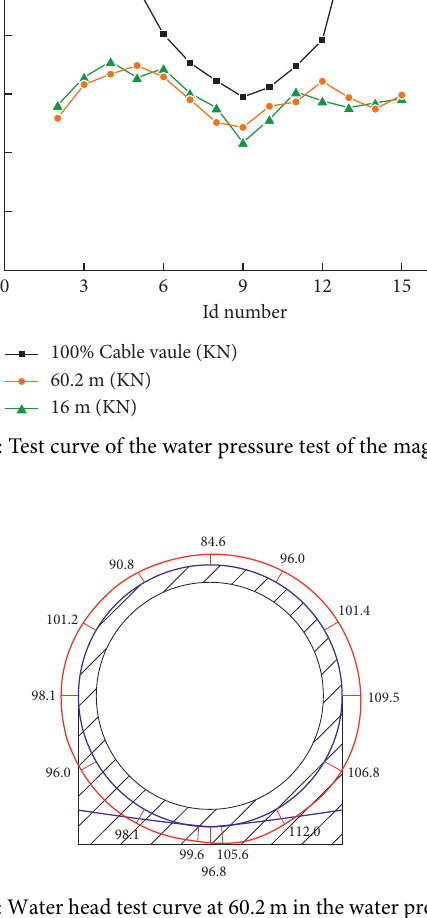
Figure 7: Test curve of the magnetic fluxsensor after soil filling